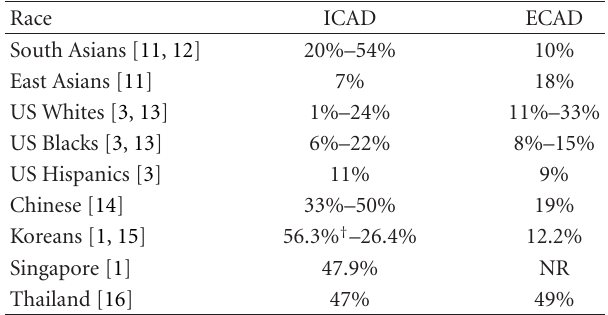
Table 1: Prevalence of intracranial atherosclerotic disease/extrac- ranial atherosclerotic disease by